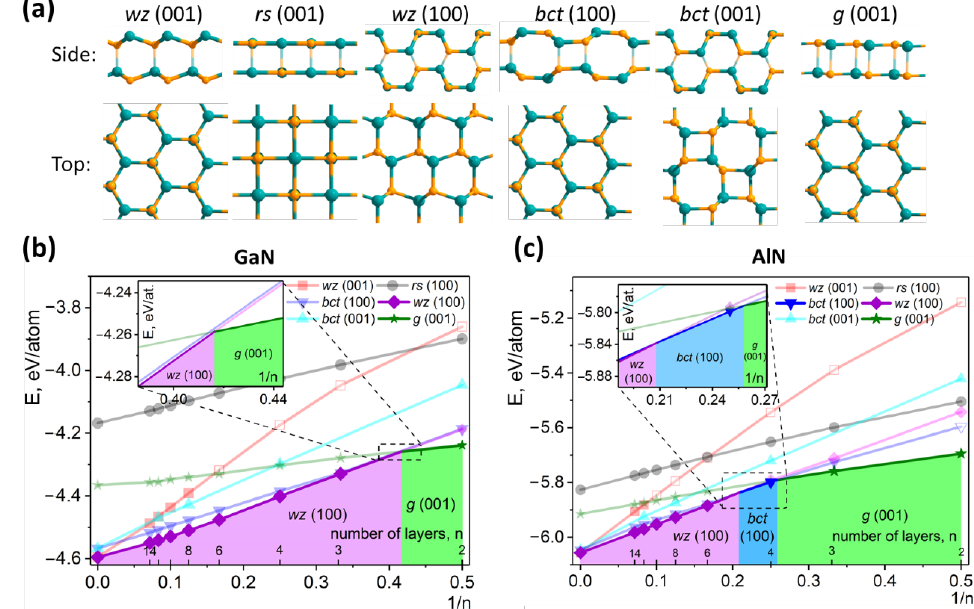
Figure 1. ( a ) Side and top views of 2D-GaN and 2D-AlN phases; ( b , c ) dependence of 2D-GaN and 2D-AlN films energy on the inverse number of layers, 1/n (horizontal axis also contains ticks denoting noninverted n). The region of phase transition is zoomed and presented in the inset. Pale colors depict the energy dependencies of less favorable phases. In the case of bilayered structures for both systems the graphene-like phase is the favorable one. Its structure possess the most stable stacking with the superposed hexagons of neighboring planes where Ga(Al) and N atoms alternate along the c direction in agree-